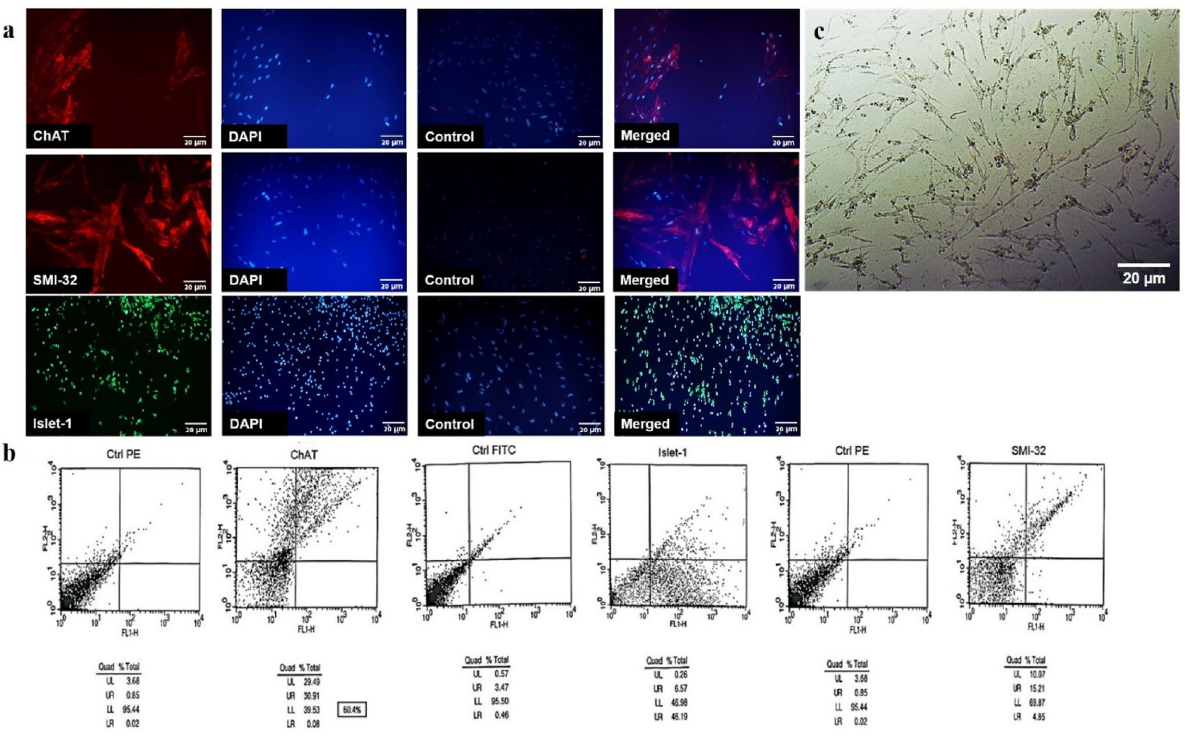
Figure 2. Differentiation of human UCB-MSCs into motor neuron- like cells using RA and Shh. The expressions of motor neuron-related markers were investigated using immunocytochemistry ( a ) and flow cytometry ( b ). The results showed that the cells could express motor neuron- related markers such as ChAT, SMI-32 and Islet-1 after induction with RA and Shh (a: scale bar: 50 µm). ( b ) Representative flow cytometry histograms illustrating the percentage of the cells expressing ChAT, SMI-32 and Islet-1 markers after induction with RA and Shh. Positive expression was defined as the level of fluorescence greater than 95% of the one measured using the matched isotype control antibody. ( c ) Human UCB-MSCs after treatment with our 14 days treatment protocol. A small number of the cells died; while the survived ones displayed the elongated morphology. (scale bar: 50 µm).